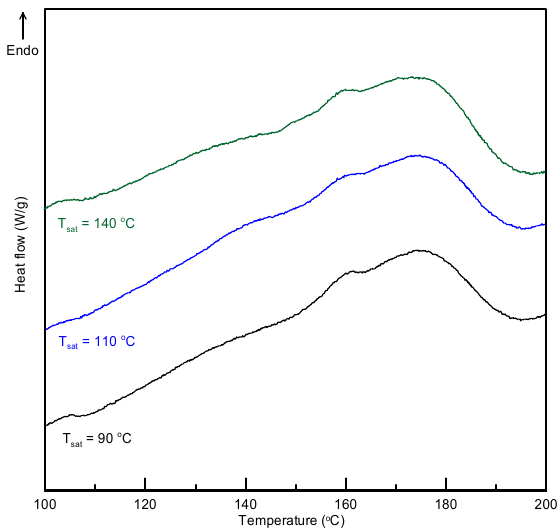
Figure 9. Effect of operating parameters on the cell density of microcellular foam of TPU: ( a ) effect of saturation pressure, ( b ) effect of saturation temperature.